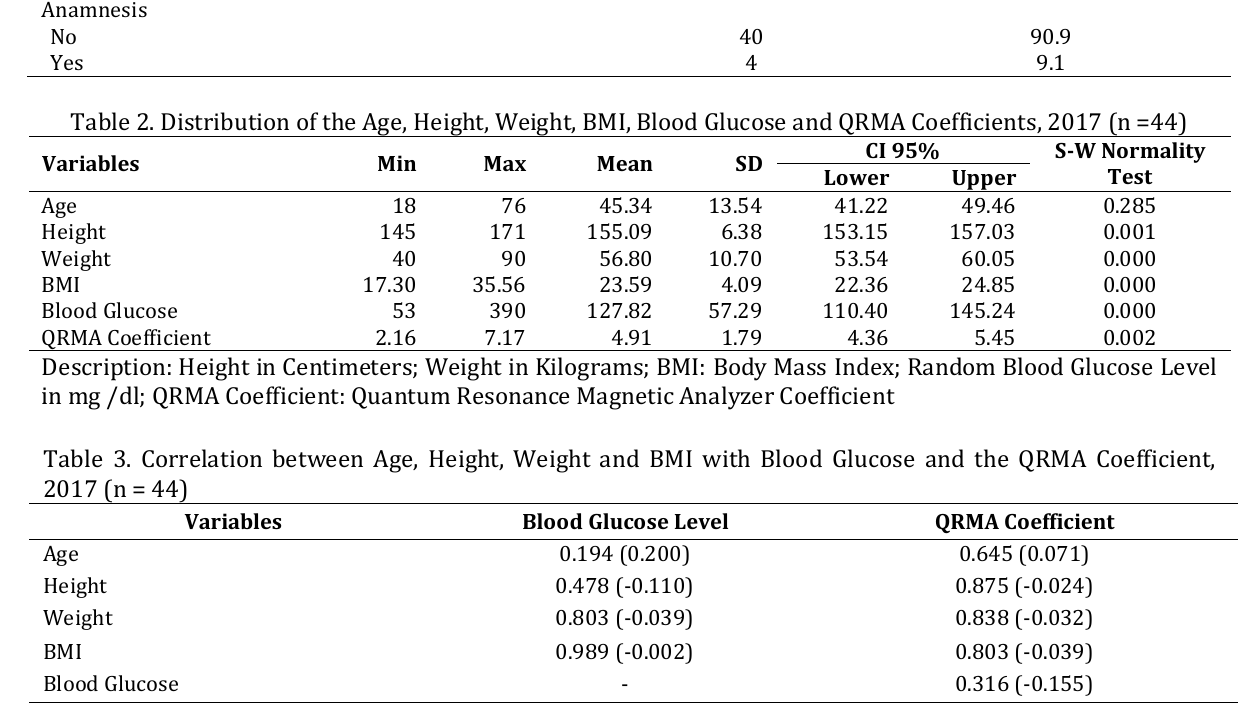
Table 4. Test of the Differences in the Blood Glucose and Coefficient QRMA values with the Results of the Anamnesis, 2017 (n = 44)